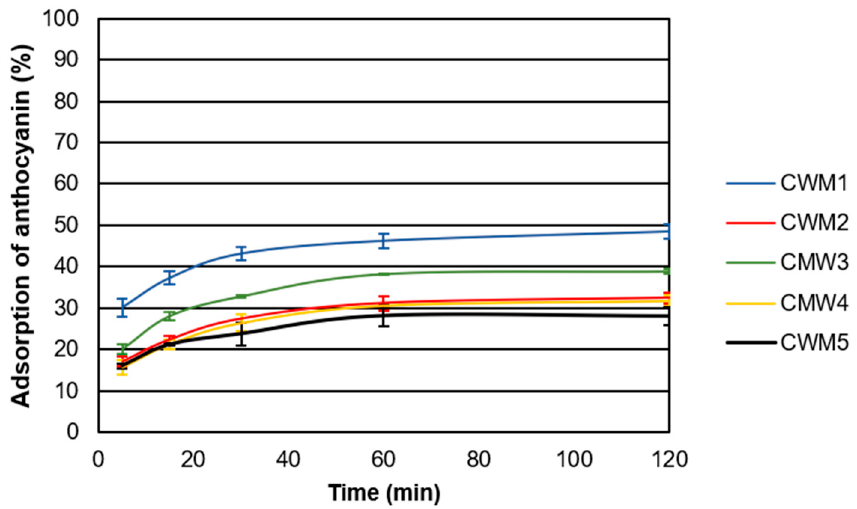
Figure 1. Adsorption kinetics for different types of CWM obtained at 15 °C in the presence of alcohol (15% EtOH) ( n = 3). Error bars represent the standard deviation of replicate measurements ( n = 3).